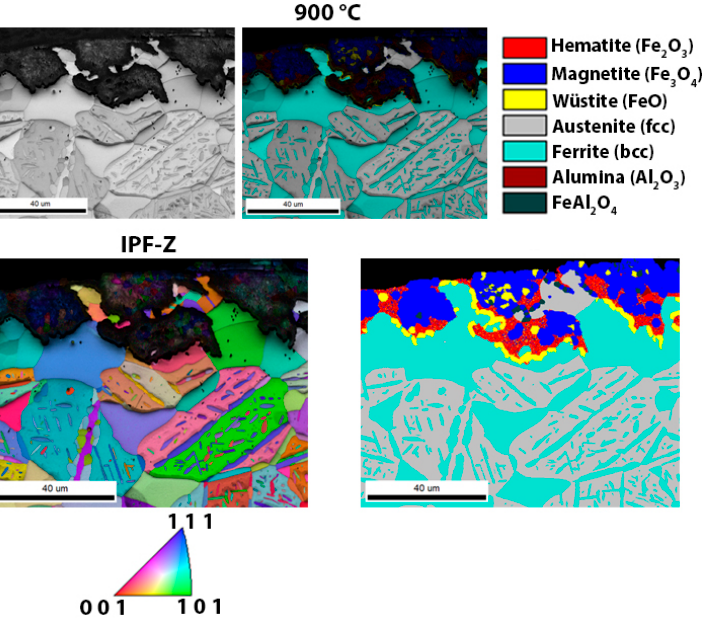
Figure 8. EBSD phase analysis of the oxide layer after high-temperature oxidation at 900 °C, phase analysis and the crystal orientations in the oxide layer formed.